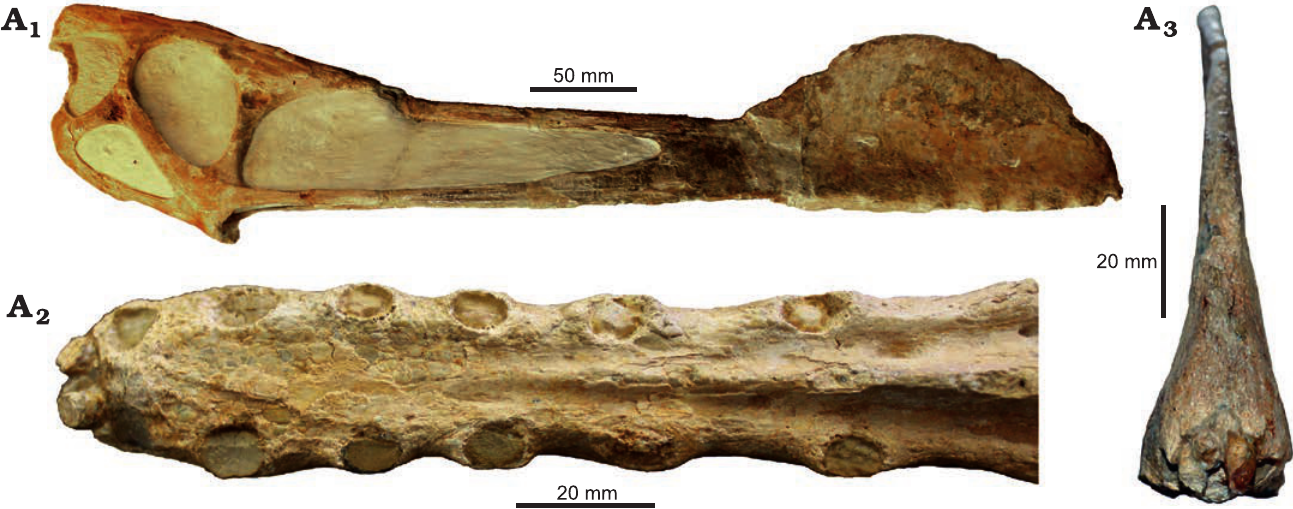
Fig. 9. Tropeognathine pterosaur Tropeognathus mesembrinus Wellnhofer, 1987, BSPG 1987 I 47, Chapada do Araripe, Ceará, Brazil, Albian. In right lateral (A 1 ), palatal (A 2 ), and anterior (A 3 ) views. Photographs by RVP (A 1 ) and BH (A 2 ). A 3 modified from Rodrigues and Kellner